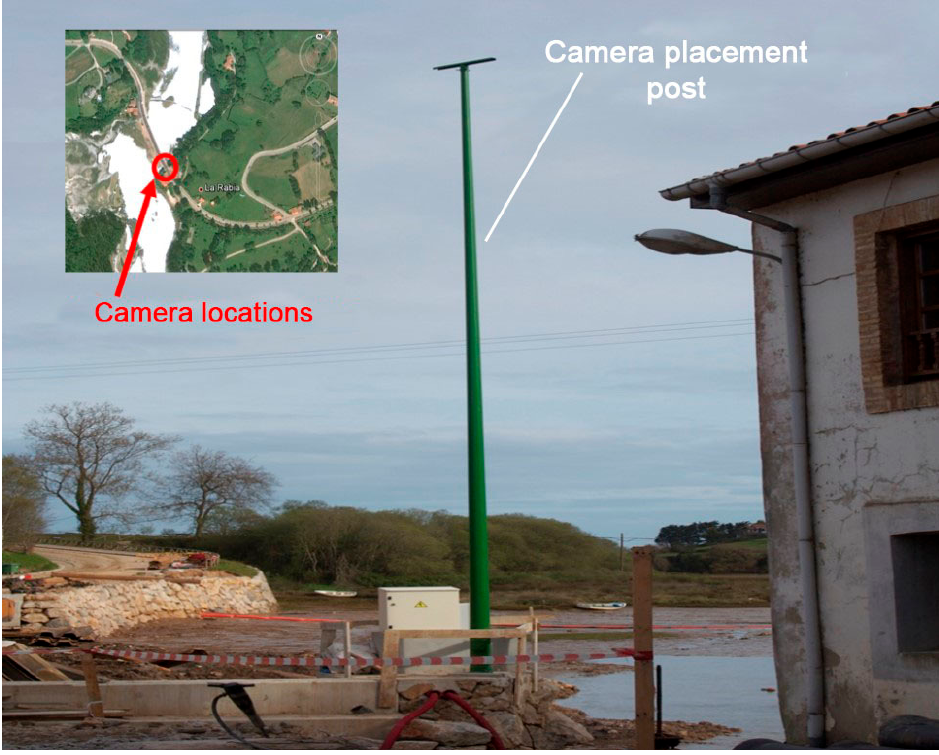
Figure 3. Spatial placement of the cameras in the La Rabia estuary.